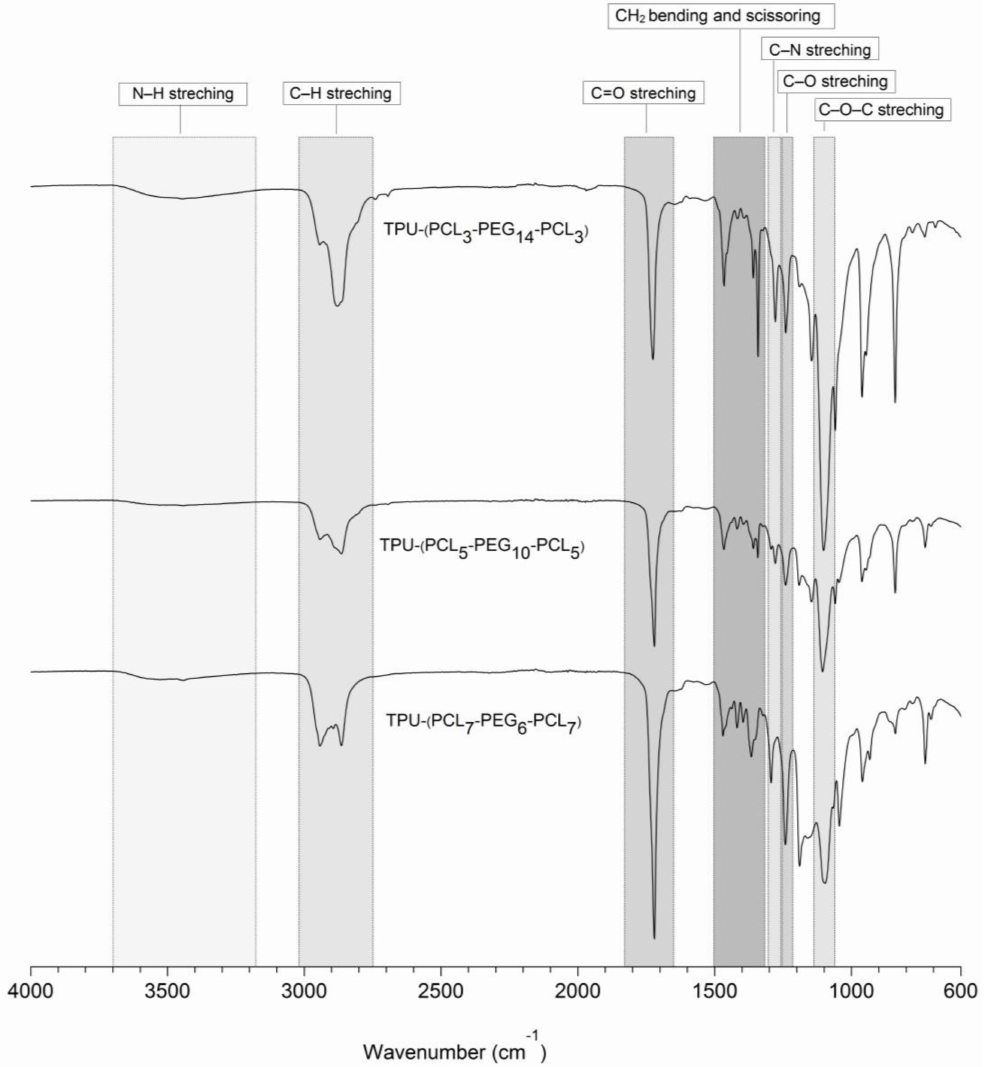
Figure 4. FTIR spectra of synthesized TPUs based on PCL- b -PEG- b -PCL triblock